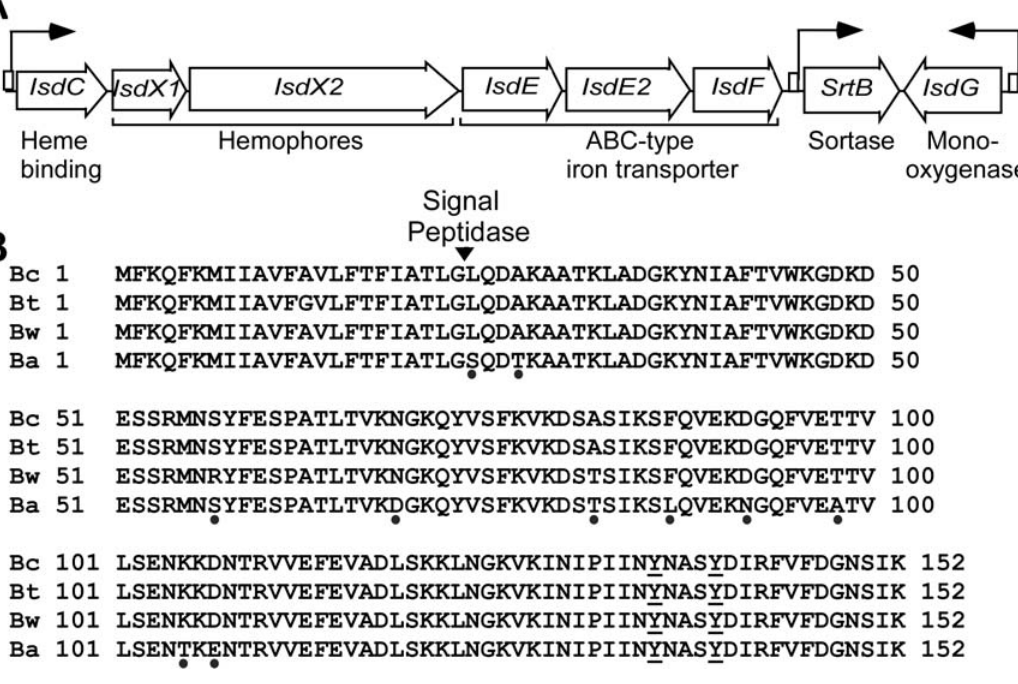
Figure 1. BacillusanthracisisdX1 and isdX2 . ( A ) The B. anthracis isd locus contains eight open reading frames, including genes for sortase B ( srtB ), IsdC (a NEAT domain protein and sortase B substrate), IsdE1-IsdE2-IsdF (ABC membrane transporter), IsdG (heme mono-oxygenase), and two NEAT domain proteins of unknown function (IsdX1 and IsdX2). ( B ) Alignment of amino acid sequences of B. anthracis IsdX1 (Ba - BAS4443) with homologs from B. cereus (Bc - BC4548), B. thuringiensis (Bt - RBTH03454), and B. weihenstephanensis (Bw - KBAB44137). Arrow indicates the predicted signal peptide cleavage site. Black dots refer to amino acids that are not absolutely conserved. Amino acids 27–152 of IsdX1 represent a NEAT (near iron transporter) domain. Tyrosine residues 136 and 140, which are conserved in many NEAT proteins, are